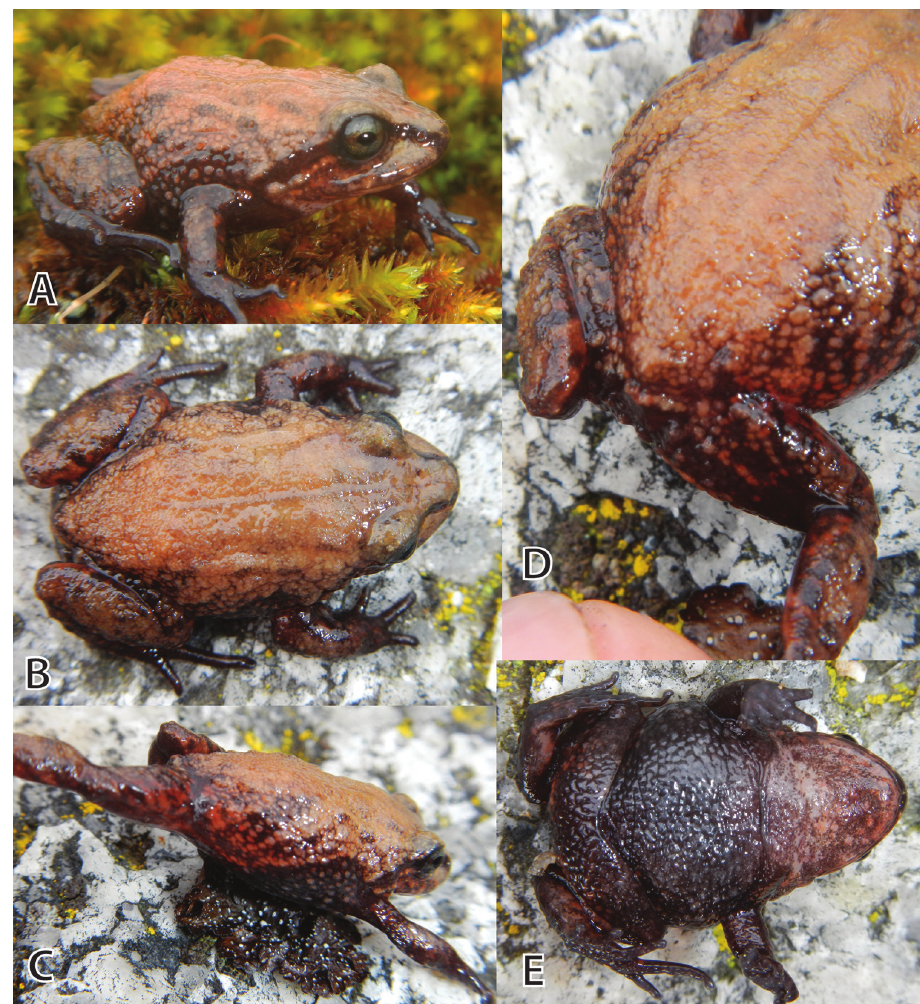
Figure 3. Life male holotype (MUSM 31196, SVL 18.9 mm) of Pristimantis attenboroughi sp. n. in dorsolateral view ( A ), dorsal view ( B ), flanks, groin, anterior surfaces of thighs ( C ), posterior surfaces of thighs ( D ), and ventral view ( E ). Photos by E.